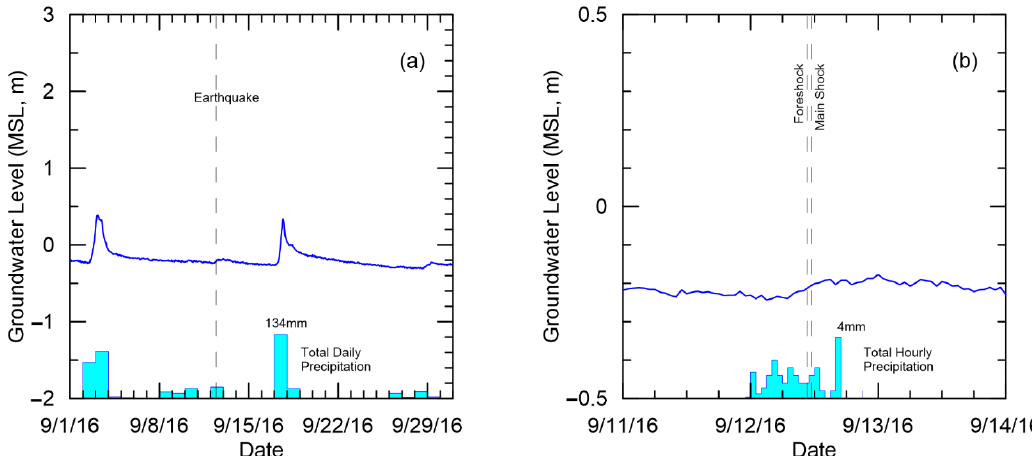
Figure 8. Groundwater level changes for well W3 during ( a ) September 2016 and ( b ) a closer inspec- tion of the 3 days around the earthquake event.